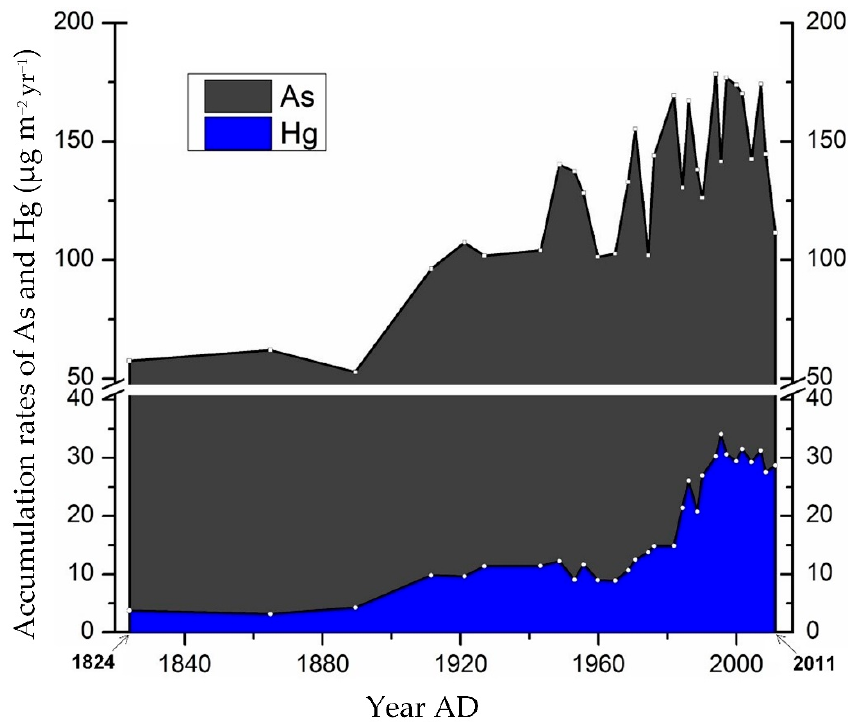
Figure 4. Historical records of accumulation rates of Hg (grey part) and As (blue part).